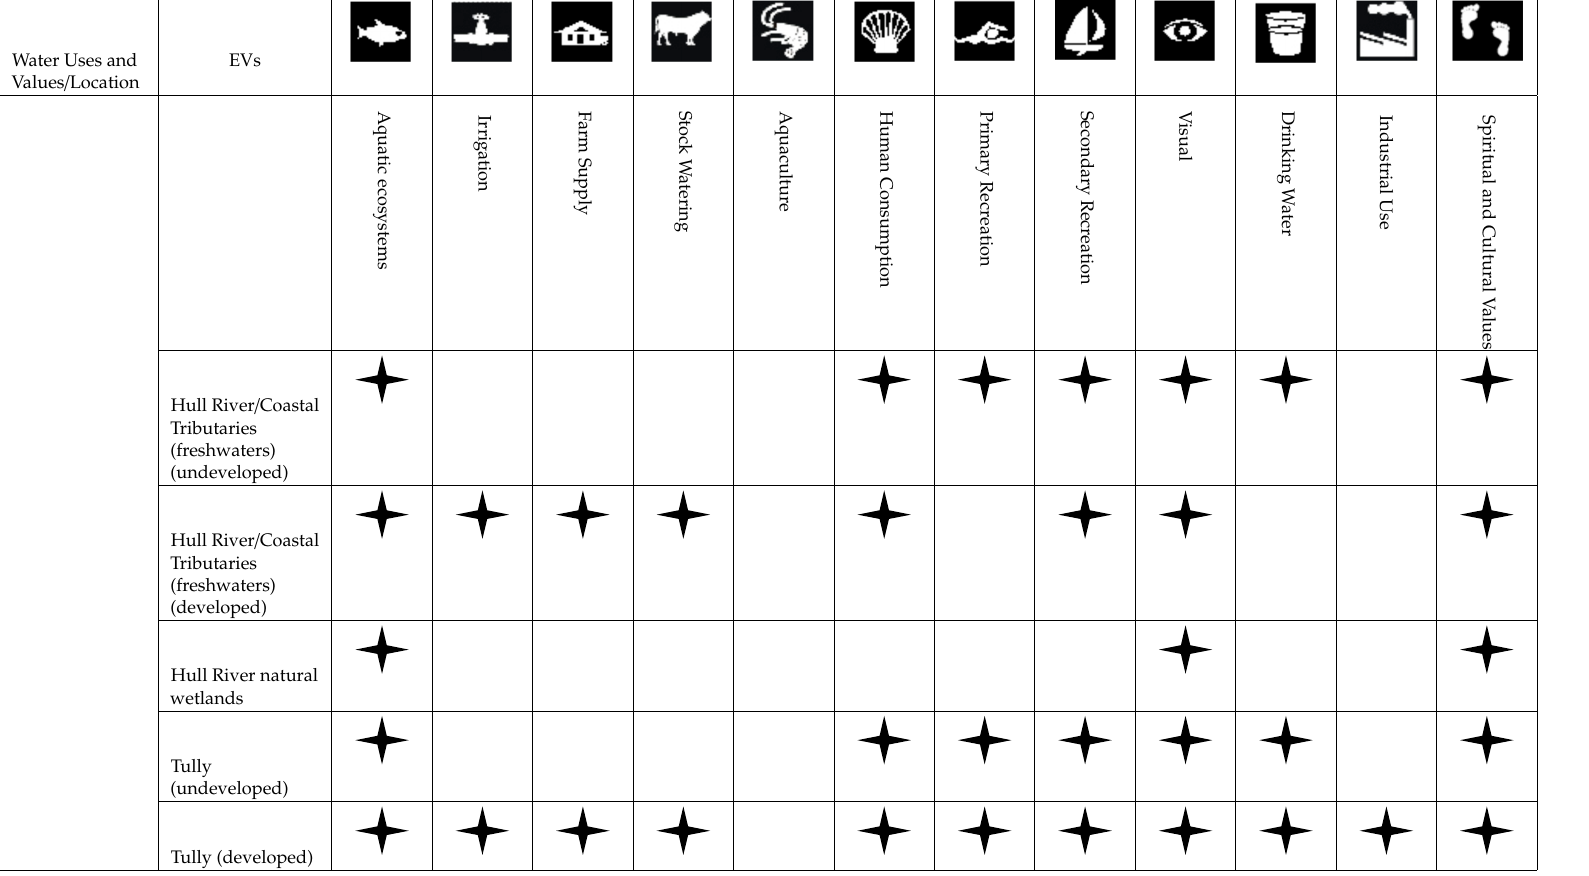
Table A1. List of EVs * Summarised for the Tully Basin EVs (as a result of this current research.